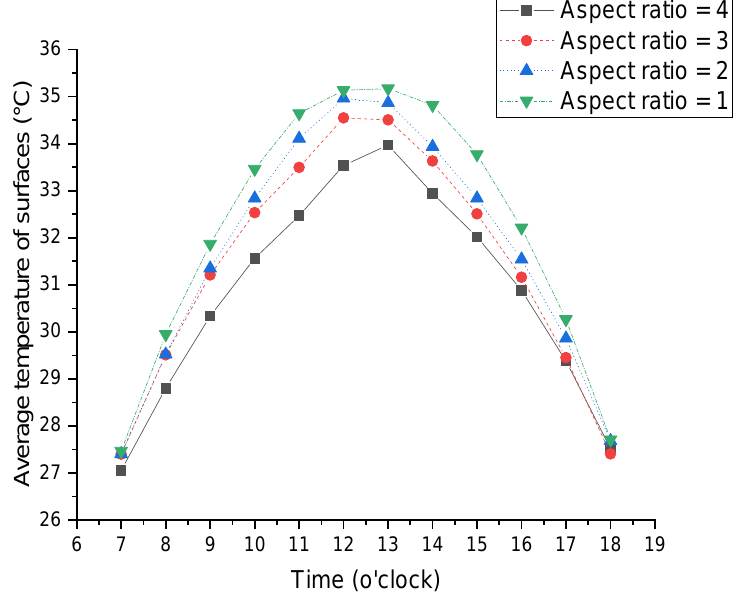
Figure 17. Variation of the hourly average temperature under different aspect ratios during the day.